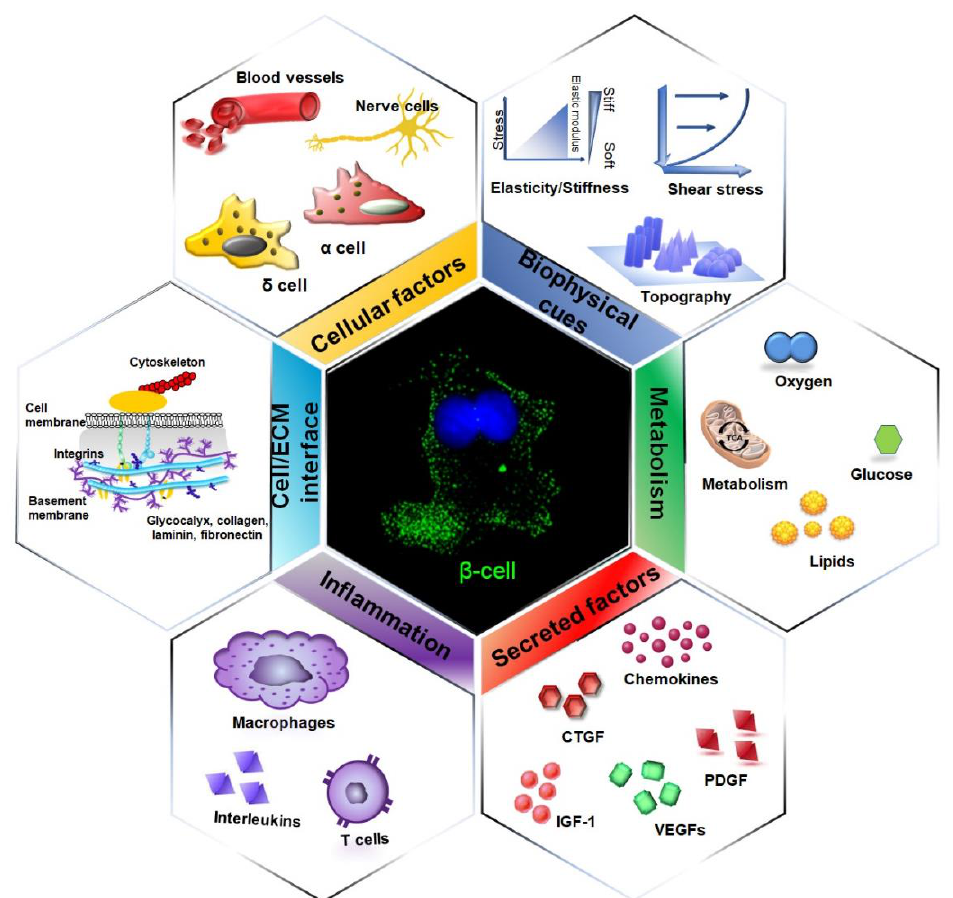
Figure 1. The islet niche and the extracellular factors influencing β-cell development, differentiation, and function. The islet niche is a complex and multi-factorial microenvironment that is characterized by the presence of different cells, a specific extracellular matrix, and several chemical, metabolic, and physical cues. The interactions between β-cells and their environment are extremely dynamic and bidirectional, as β-cells perceive the extracellular signals and respond to them, thus shaping the niche architecture.